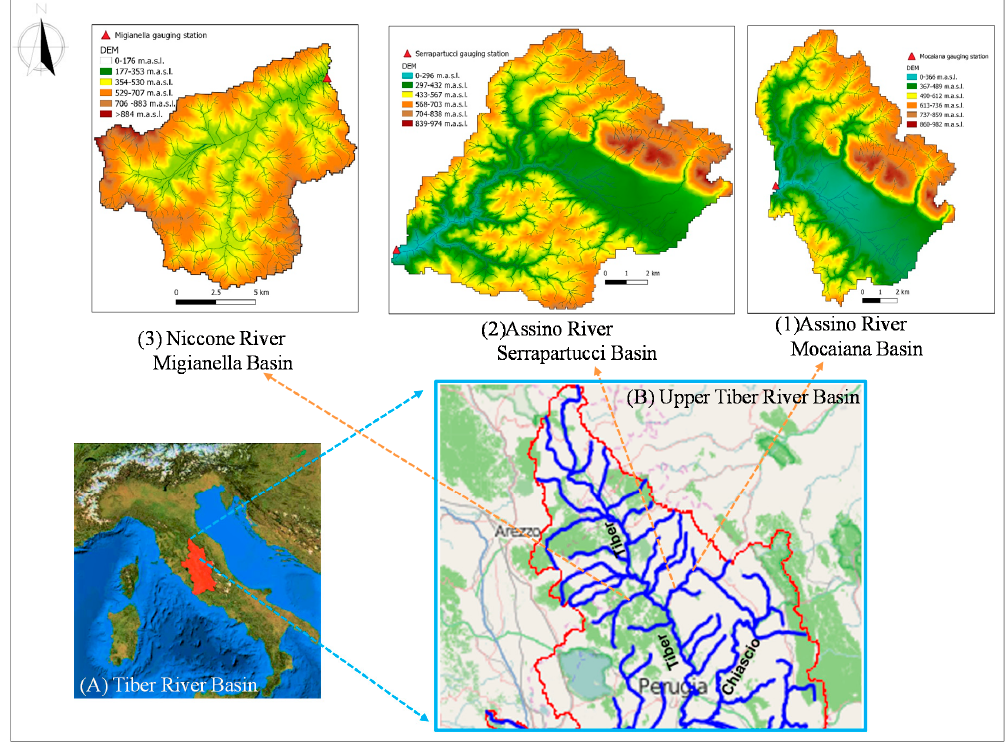
Figure 1. Map of the Tiber River Basin ( A ) and Upper Tiber River Basin ( B ) with the location of case study basins. Table 1. Key characteristics of case study basins: observation periods, catchment area, Base Flow Index, and water